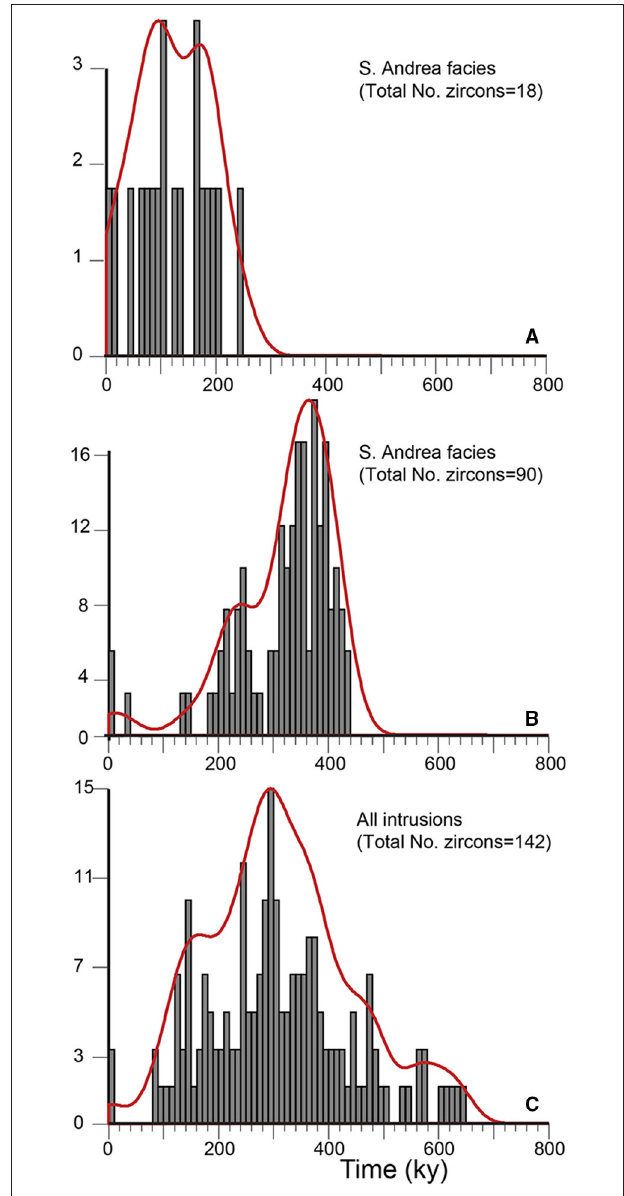
FIGURE 10 | (A) Distribution of zircon crystallization times for the S. Andrea facies from Barboni et al. (2015). (B) Distribution of zircon crystallization times for the S. Andrea facies from Barboni and Schoene (2014). (C) Distribution of crystallization times reported by Barboni et al. (2015) for all intrusions of Elba